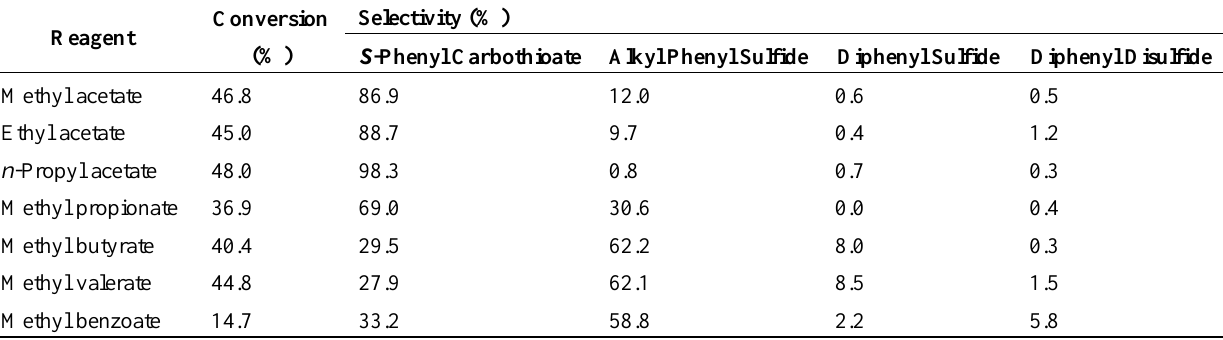
Table 12. S -Acylation and S -alkylation of benzenethiol with esters over a . [(Nb Cl )Cl (H O) ]·4H O/SiO 6 12 2 2 4 2 2 Selectivity (%) Conversion Reagent (%) S -Phenyl Carbothioate Alkyl Phenyl Sulfide Diphenyl Sulfide Diphenyl Disulfide Methyl acetate 46.8 86.9 12.0 0.6 0.5 Ethyl acetate 45.0 88.7 9.7 0.4 1.2 n -Propyl acetate 48.0 98.3 0.8 0.7 0.3 Methyl propionate 36.9 69.0 30.6 0.0 0.4 Methyl butyrate 40.4 29.5 62.2 8.0 0.3 Methyl valerate 44.8 27.9 62.1 8.5 1.5 Methyl benzoate 14.7 33.2 58.8 2.2